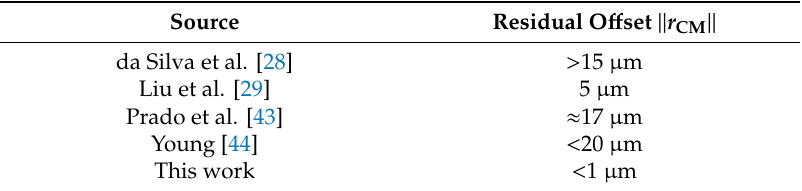
Table 3. Residual o ff set vector after